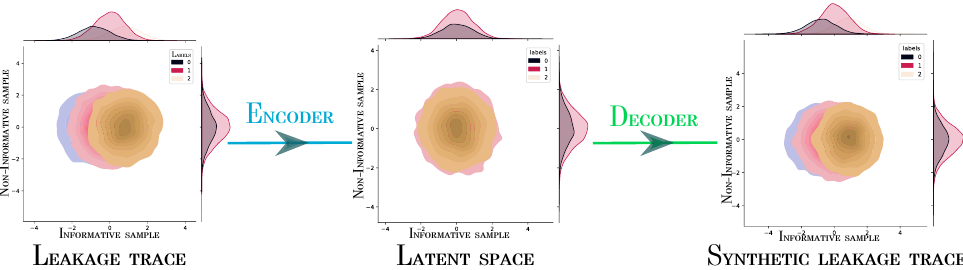
Figure 7: Evolution of the distributions over the cVAE-SA model when a successful attack is performed ( F 2